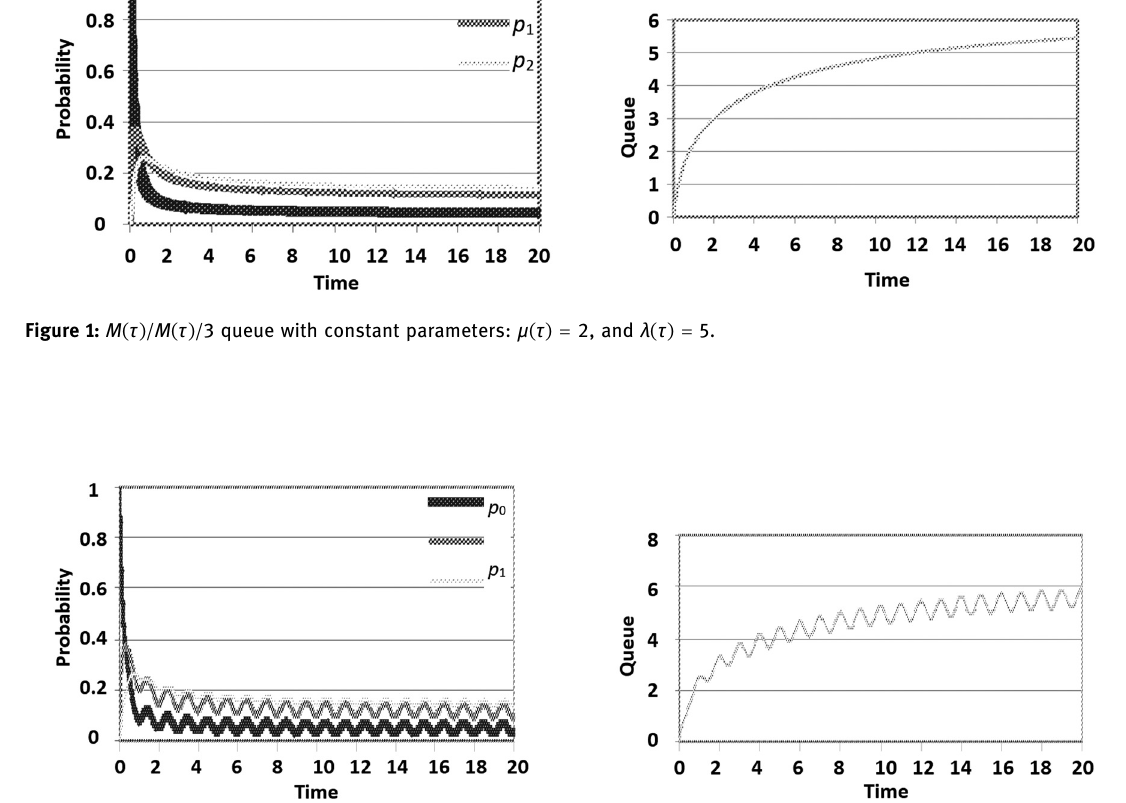
Figure 2: ( ) ( ) / / M τ M τ 3 queue with variable service rate: ( ) = + μ τ πτ 2 sin2 , and = λ 5